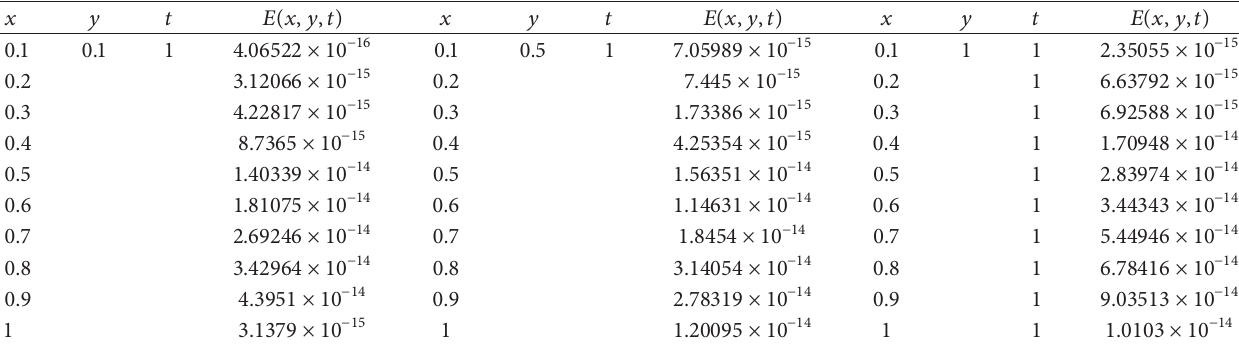
Table 4: Maximum absolute errors for problem (46) for 𝑇 = 1 and ] 1 = ] 2 = 1.5